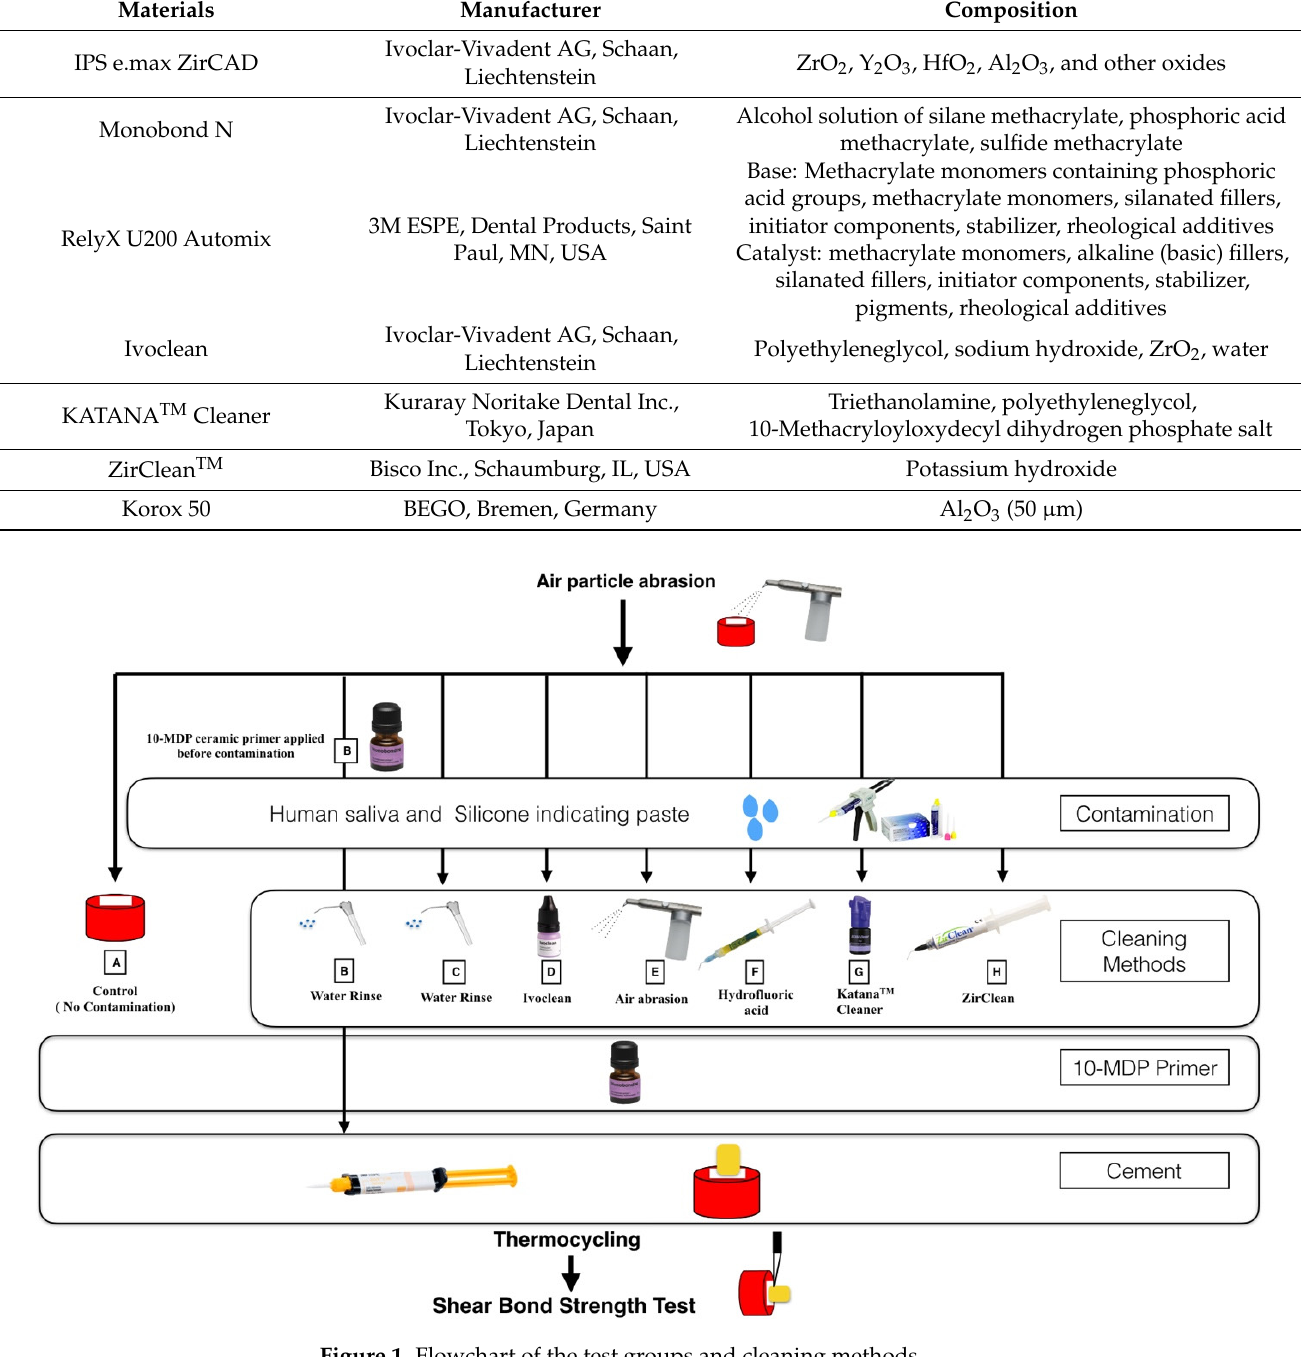
Table 1. Summary of the products used in the study.